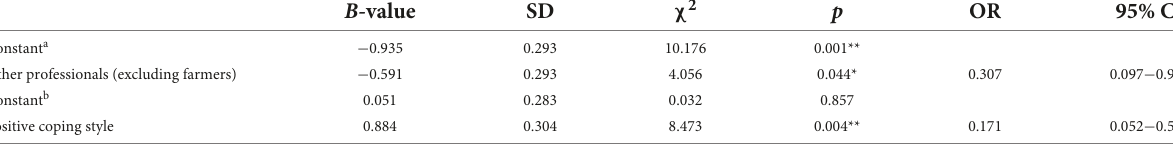
TABLE 5 Logistic regression analysis of influencing factors on emotional support. B -value SD χ 2 p OR